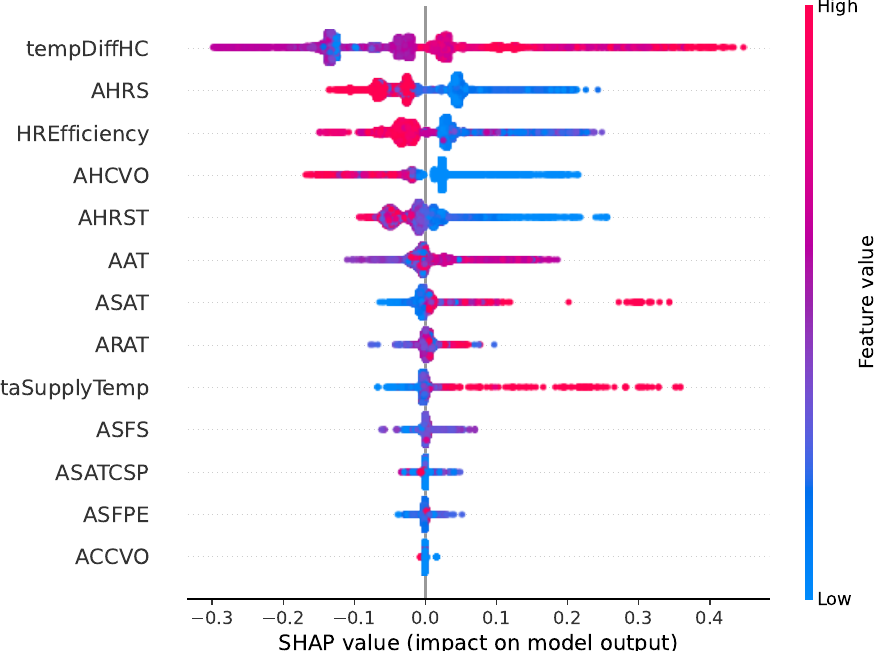
Figure 7. Summary of the effects of all the features on the random forest model prediction of the fault type “Heating coil valve